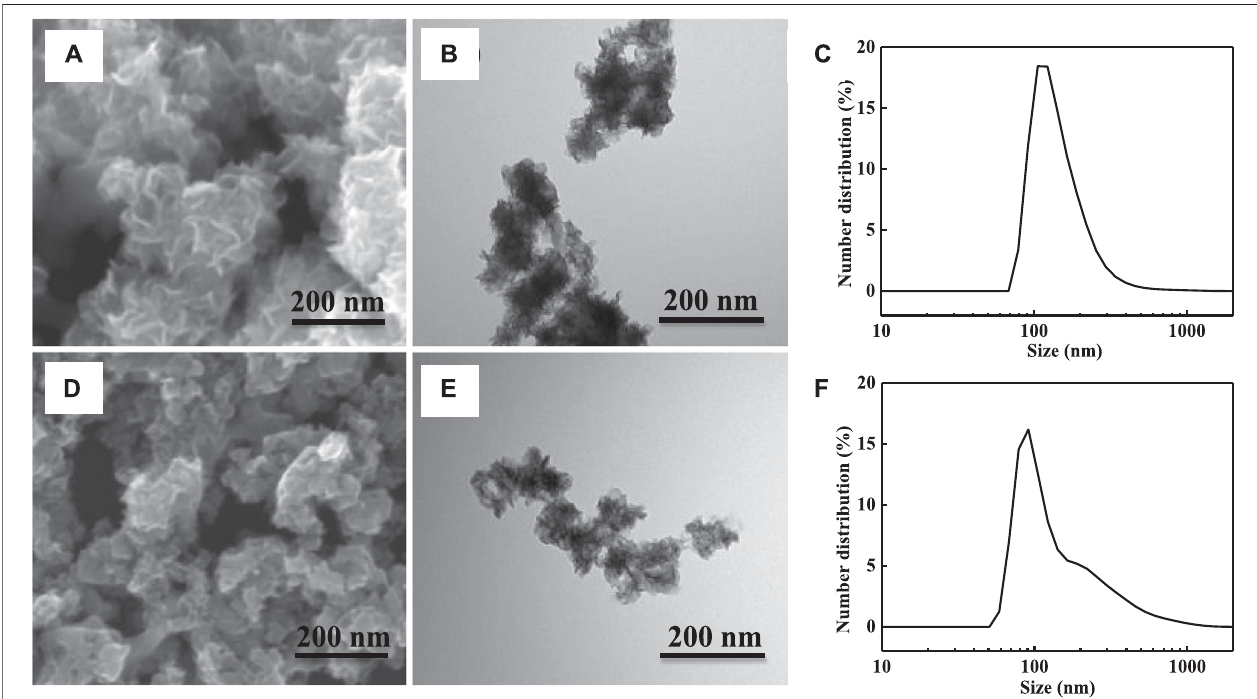
FIGURE 1 | (A) SEM image of undoped MoSe 2 nanoparticles, (B) TEM image of undoped MoSe 2 nanoparticles, (C) size distribution of undoped MoSe 2 nanoparticles, (D) SEM image of carbon-doped MoSe 2 nanoparticles, (E) TEM image of carbon-doped MoSe 2 nanoparticles, and (F) size distribution of carbon-doped MoSe 2 nanoparticles.